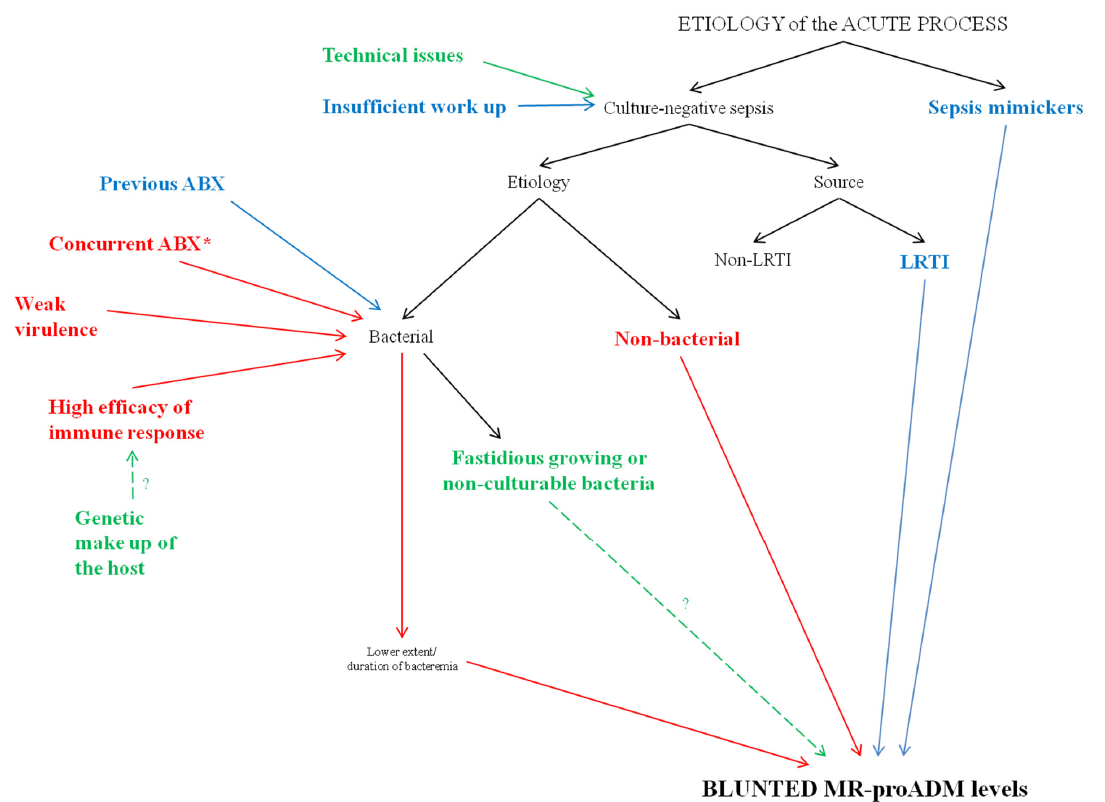
Figure 4. Motivations of culture-negative status: the hypothetical size of their impact on the genesis of culture-negative sepsis in this study. List of abbreviations: ABX: antibacterial therapy, LRTI = lower respiratory tract infection, MR-proADM = mid-regional proadrenomedullin. Size of the impact: red = high-moderate, blue = low, and green = unknown. * = according to previous studies [3–5].